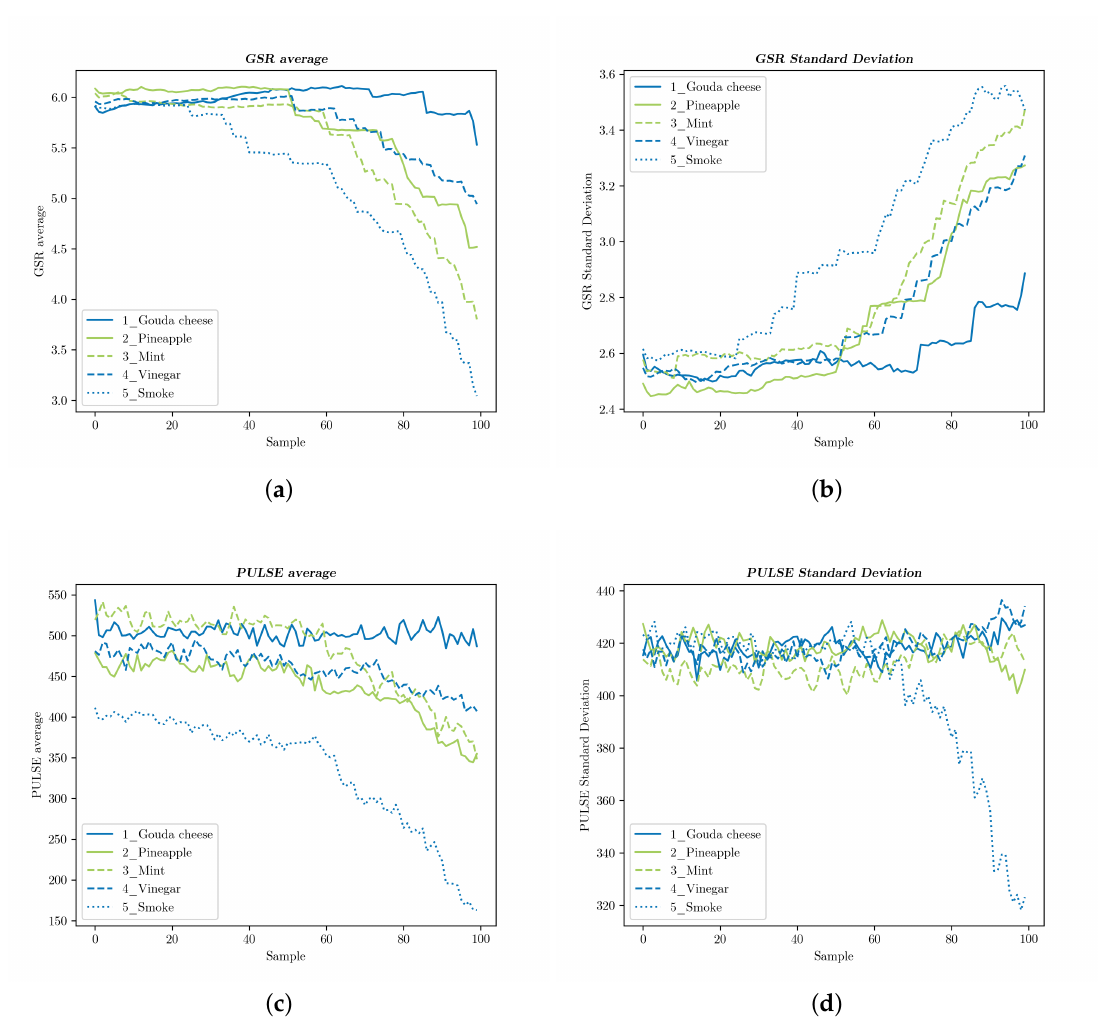
Figure 17. GSR and pulse measurements for the smell tests. ( a ) The participants’ GSR average values and ( b ) standard deviation. ( c ) The participants’ pulse average values and ( d ) standard